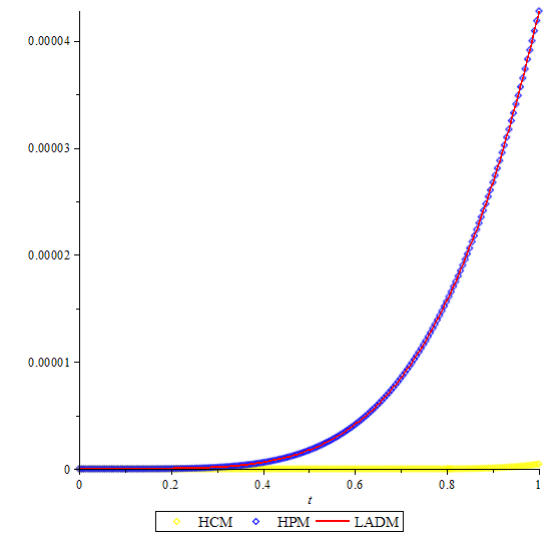
Figure 2. Comparison of the error function E 2,5 ( t ) for I ( t